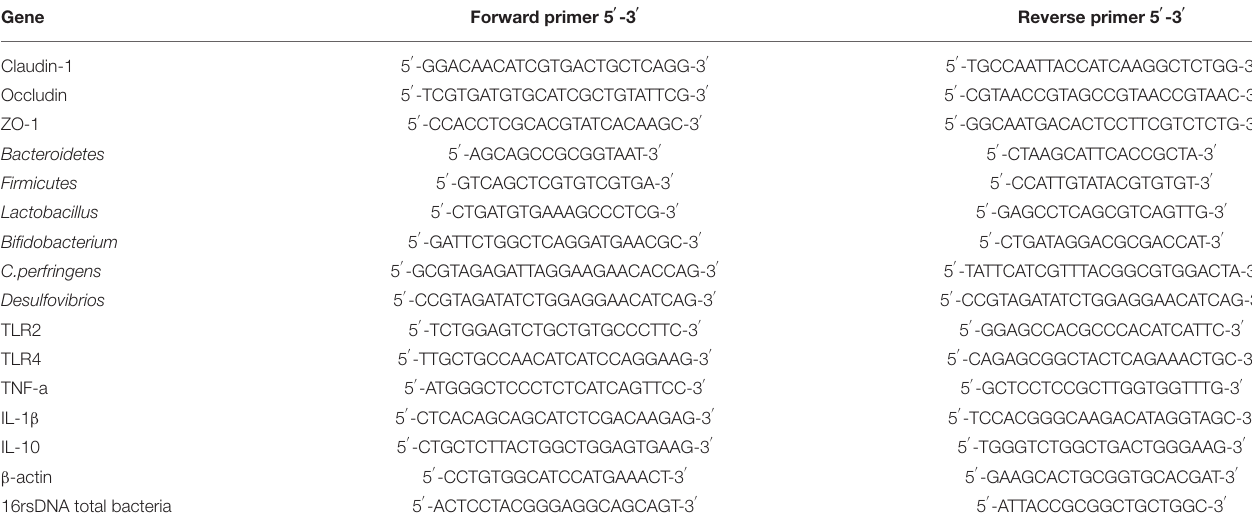
TABLE 2 | The primer sequences of Real time-PCR. Gene